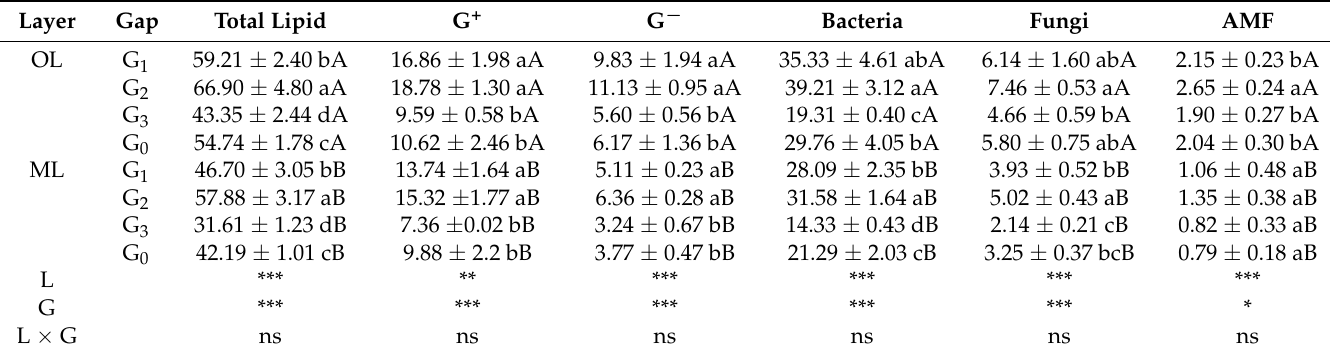
Table 3. Soil microbial communities in the organic and mineral soils from four treatments. Values are the mean ± standard deviation (n =